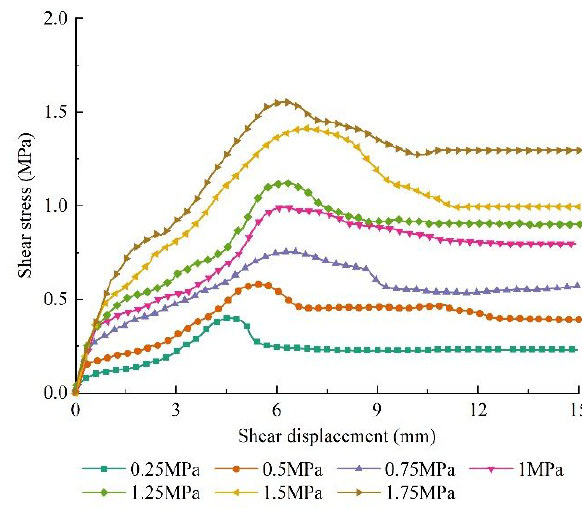
Figure 15: Shear stress-displacement curve of double saw-tooth rock joints under different normal stresses (scale=100mm)